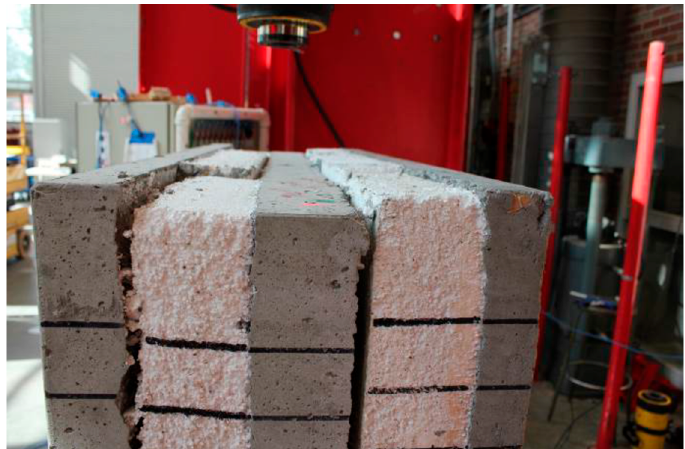
Figure 18. View of a typical failure mode showing shear between wythes.